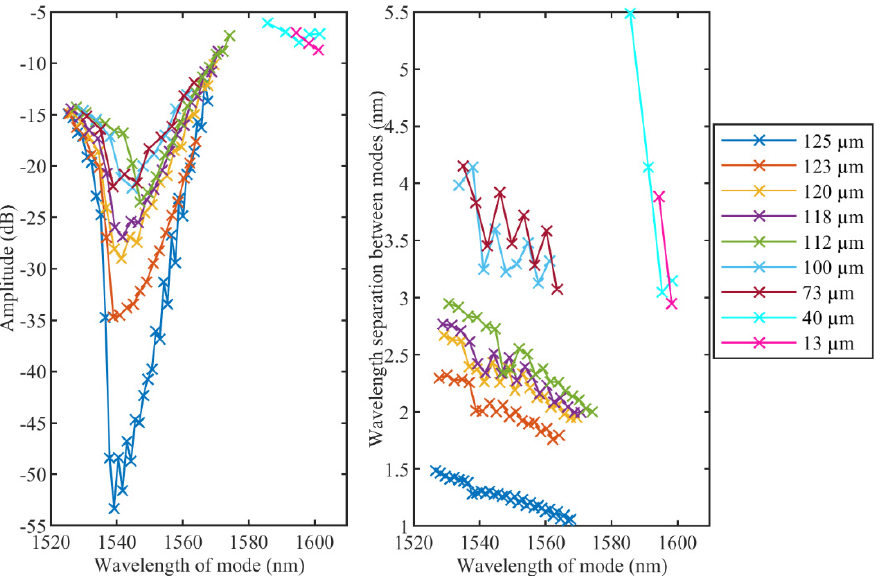
Figure 5. Evolution of amplitude levels ( left ) and wavelength spans ( right ) of cladding modes during etching process. Only modes which are distinguishable for both RI variation ranges are illus- trated.